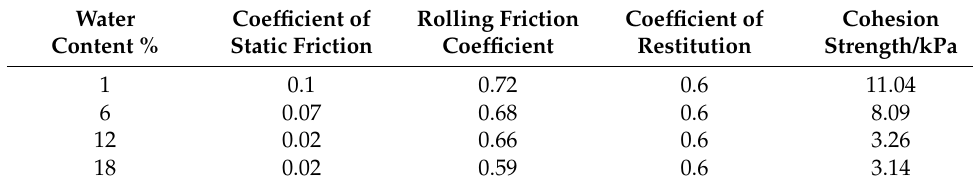
Table 2. Predicted simulation parameters of sandy soil.